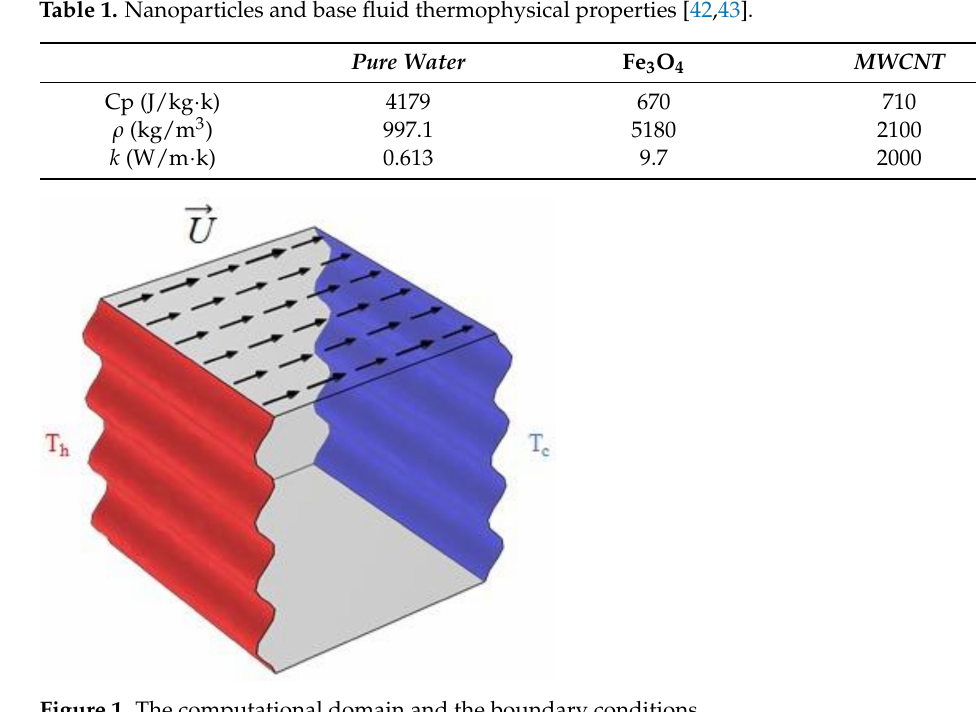
Figure 1. The computational domain and the boundary